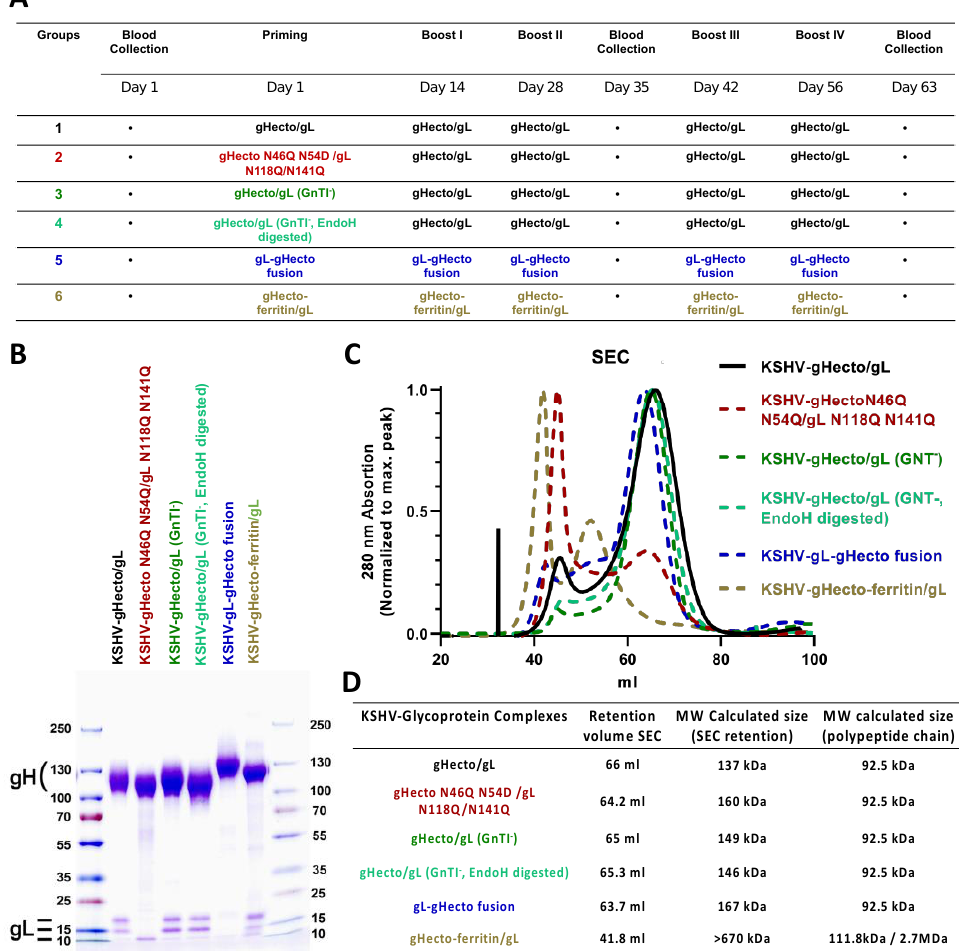
the inlet; I-IV indicate domains; gH is colored in grey and gL in purple, with their N- and C-termini represented as circles containing the letters N and C, respectively. The models are based on the experimentally determined structure of KSHV gH ectodomain/gL complex (PDB:7B7N). The termini of gL (res 129–167) and gH (res 26–34 and 697–704) are not resolved in the structure indicating flexible regions. In the left panel, the putative location of the gL C-terminus (dotted purple line) is shown, with the glycosylation site N141 represented as a pink diamond. The remaining N-glycosylation sites—residues N118 in gL and N46 and N54 in gH—have their side chains represented as stick models. The linker (dashed line on the right panel) that connects the gL and gH in the chimera is formed by the flexible C-terminus of gL (res 129–167) that is joined to flexible N-terminus of gH (res 26–35) by a TGA sequence (highlighted in magenta). SP stands for signal peptide, which was a part of the expression construct.